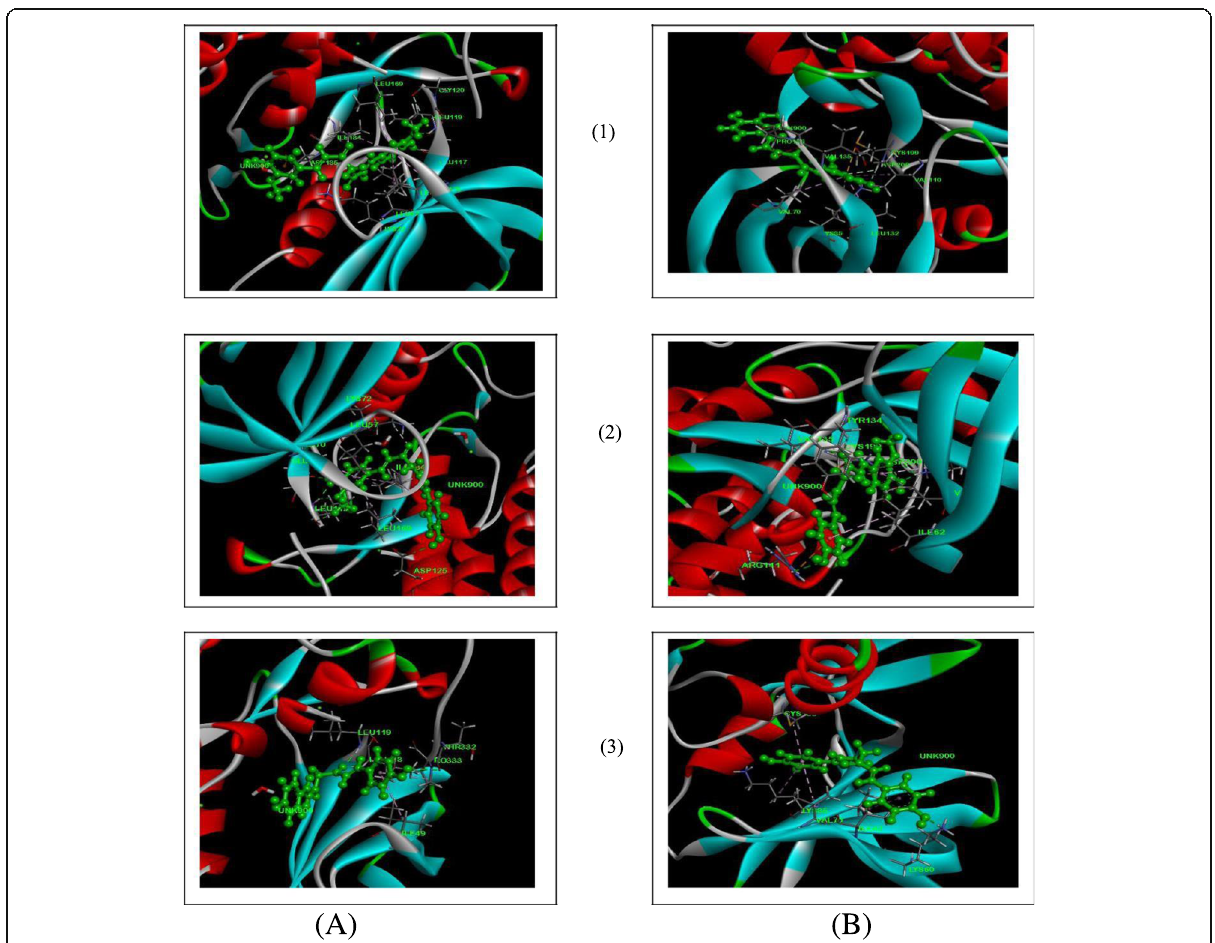
Fig. 6 3D representation of the best possible poses and ligand-receptor interactions between (1) curcumin I (PubChem CID: 969516), (2) curcumin II (PubChem CID: 5469424), and (3) curcumin III (PubChem CID: 5315472) and (A) casein kinase-1 (PDB Id: 2IZS) and ( B ) glycogen synthase kinase-3 β (PDB Id: 3F88). Ligand (UNK: 900) is represented as a ball and stick and the interacting amino acid (labeled) of the receptor is represented in a stick style. The receptor is represented in ribbon style. The dotted line represents the type of interactions: green: hydrogen bond; pink: Pi-alkyl interaction; white: carbon-hydrogen bond; red: acceptor-acceptor interaction; orange: Pi-sulfur